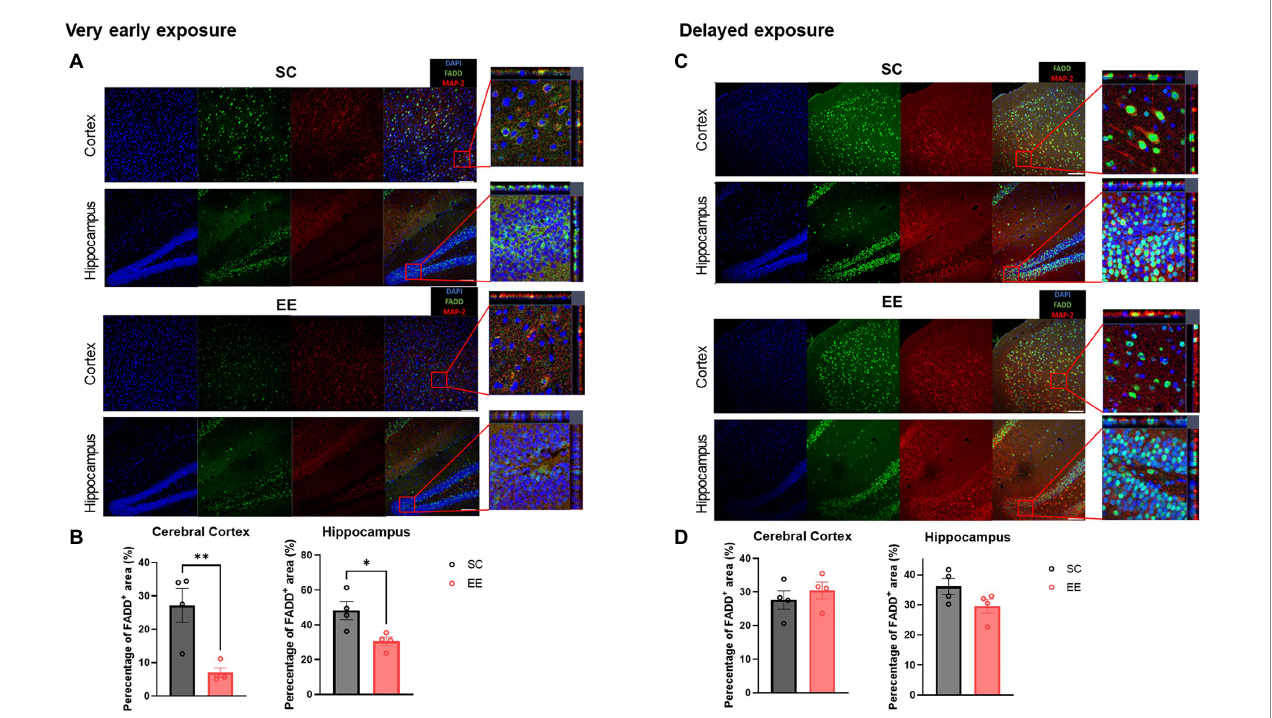
FIGURE 8 Very early, but not delayed, exposure to EE decreases colocalization of MAP-2 and FADD in the cerebral cortex and the hippocampus. (A) Representative images from the very early exposure to EE group and its control group depicting MAP-2 and FADD immunoreactivity. (B) Quantification of the percentage of colocalization ( n = 4 per group). (C) Representative MAP-2 + FADD+ images from the delayed exposure to EE group and its control group depicting MAP- 2 and FADD immunoreactivity. (D) Quantification of the percentage of colocalization ( n = 4 per group). All statistical comparisons were performed via